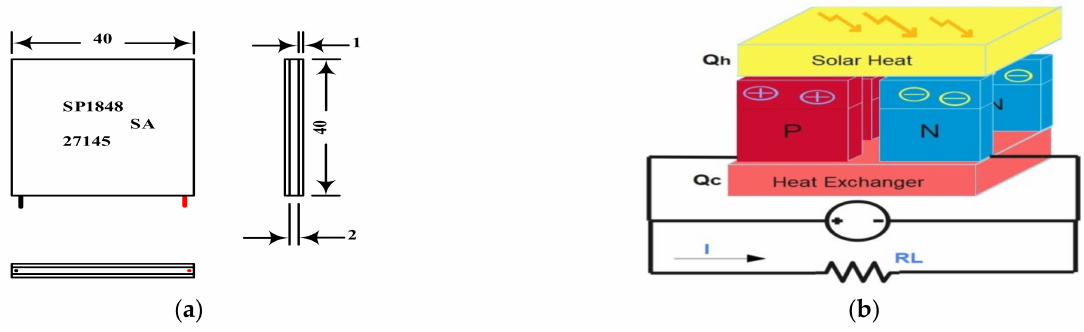
Figure 1. ( a ) Geometry of the module, ( b ) the basic structure of a TEG. Table 1. Specifications of the TEG SP1848-27145 module as given by [1,42].